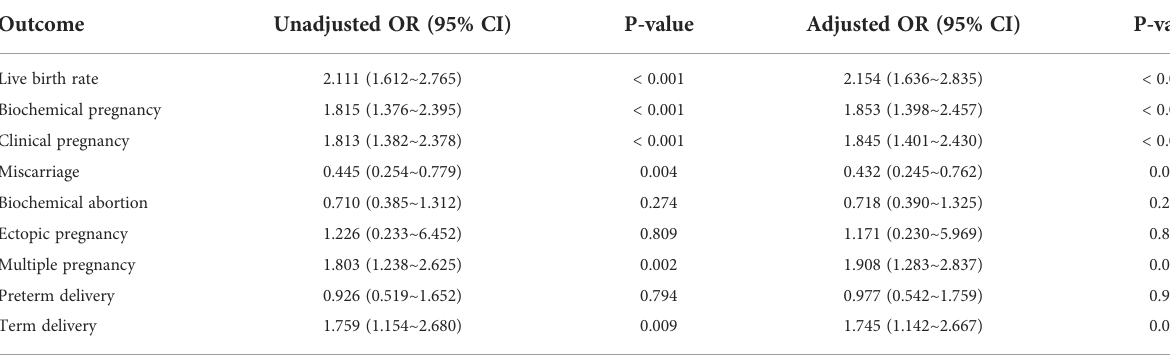
TABLE 2 Univariate and multivariate logistic analysis of pregnancy outcomes.